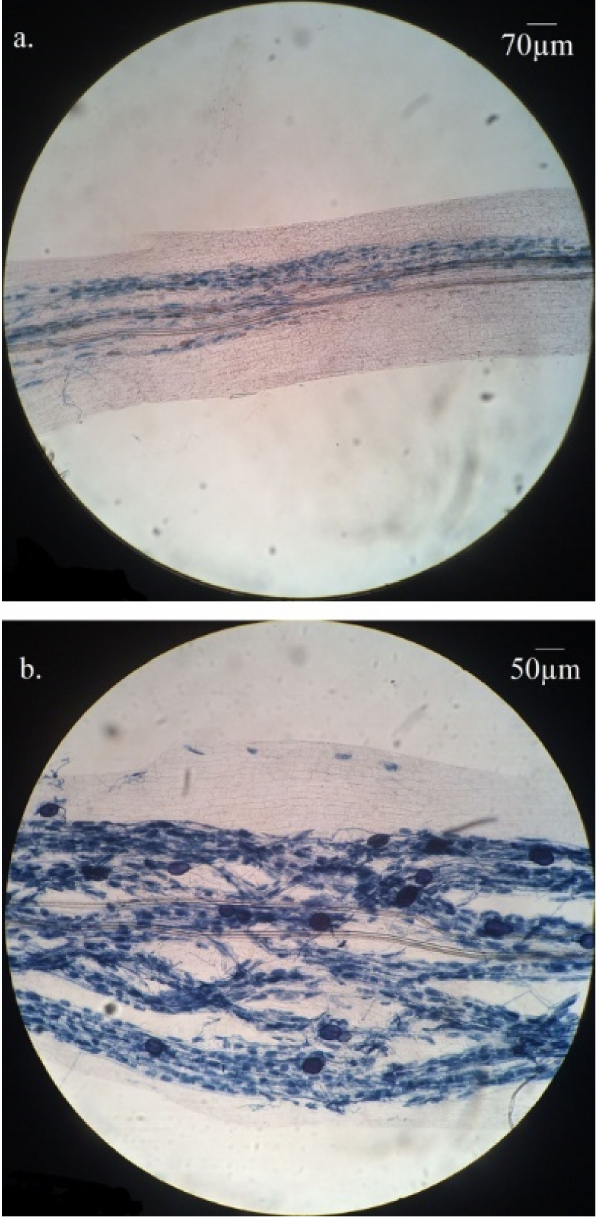
Figure 3. Microscopic observations after black Sheaffer ink staining. ( a ) arbuscules not clearly visible. ( b ) well-shaped arbuscules and many